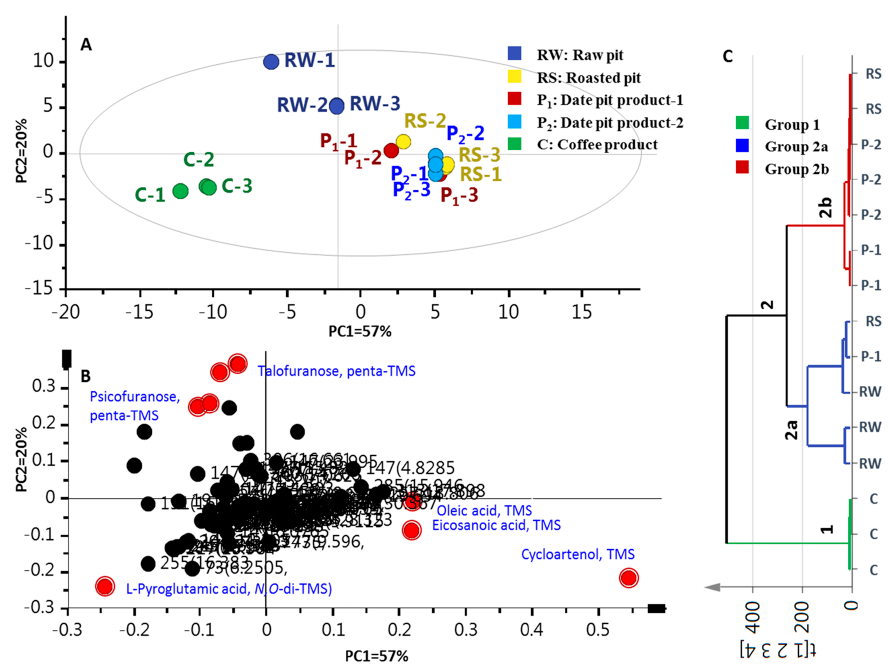
Figure 4. GCMS-post silylation based principal component analysis (PCA) and hierarchical cluster analysis (HCA) of raw pits (RW), roasted pits (RS), pit product one (P 1 ), pit product two (P 2 ) and coffee product (C) ( n = 3). ( A ) Score plot of PC1 versus PC2. ( B ) Loading plot for PC1 and PC2. ( C ) HCA of RW, RS, P 1 , P 2 and C ( n = 3); the model is colored according to marked